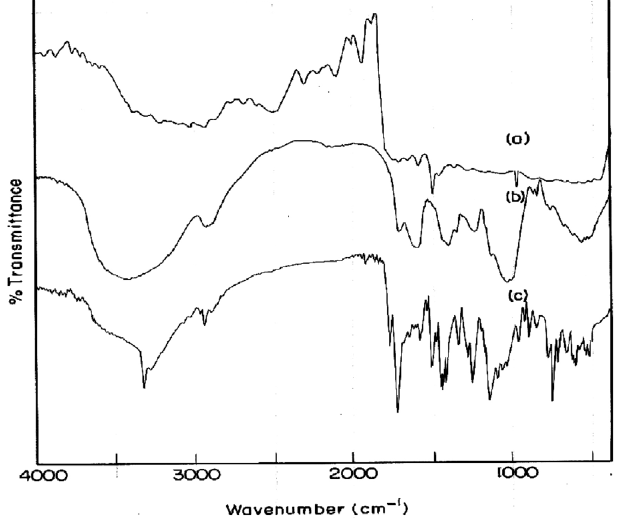
FIGURE 2 - FT-IR graphs of (a) Aceclofenac, (b) Xanthan gum, (c) Physical mixture of aceclofenac and xanthan